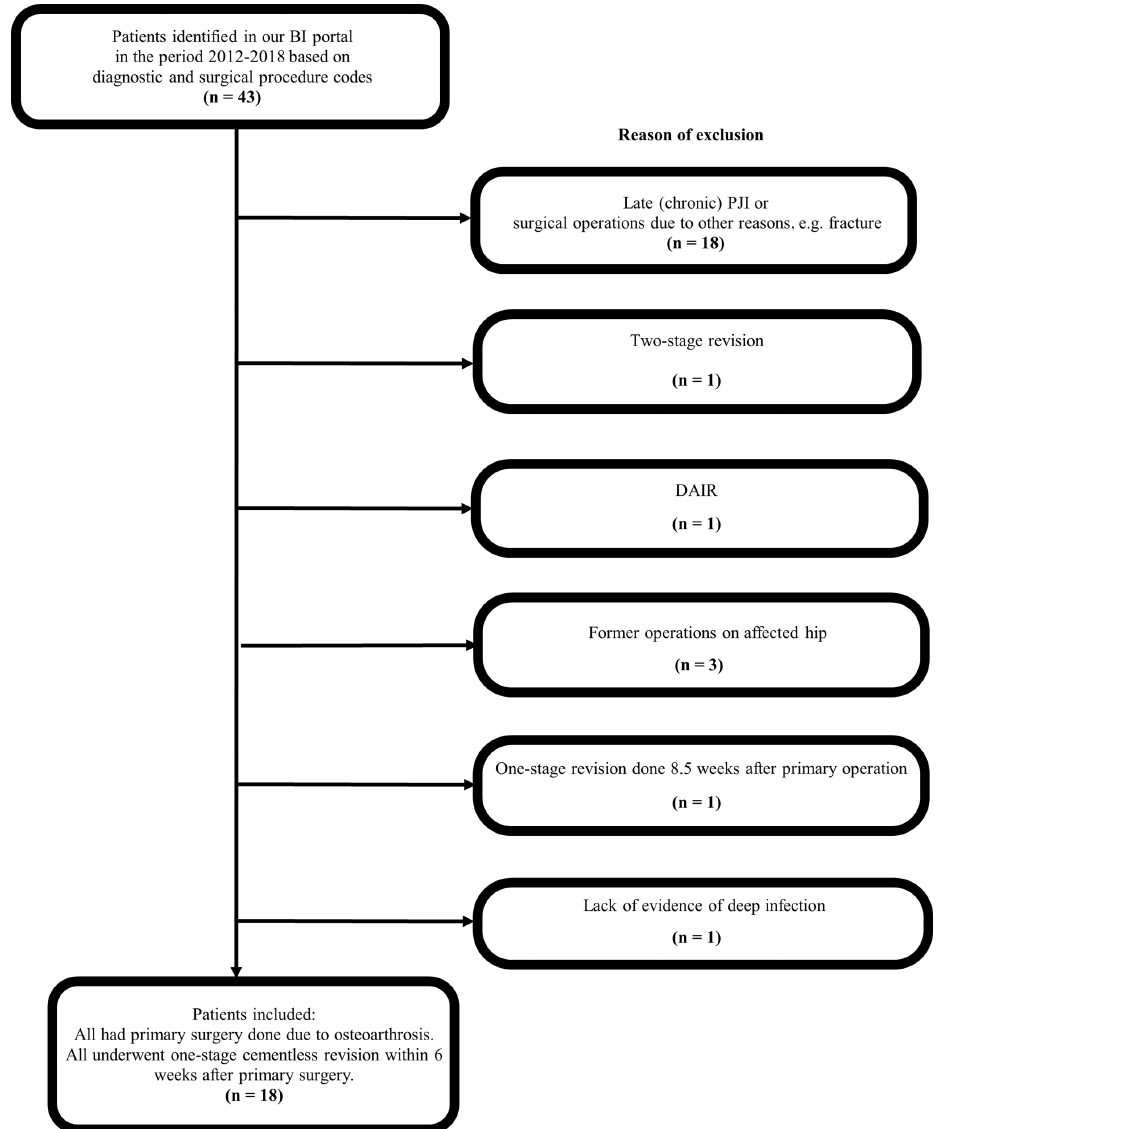
Figure 1. Flow diagram of patient